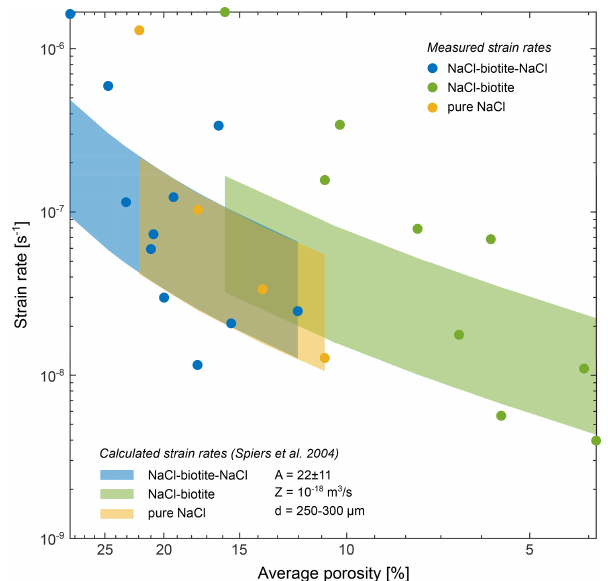
Figure 16. Comparison of bulk strain rates and calculated bulk strain rates based on the rate law by Spiers et al. (2004) for σ e (cid:127) S f (φ) with ˙ ε as the strain diffusion-controlled DPC: ˙ ε = A DCS RT d 3 rate, DCS = Z a phenomenological coefficient which represents the effective grain boundary diffusivity, d the grain size, σ e the effective axial stress, (cid:127) S the molar volume of the solid, R the gas constant, T the absolute temperature and f (φ) = 2 φ/( 1 − 2 φ) 2 as a function of the porosity ( φ ). For the calculation, the parameters A and Z were used as given in Spiers et al. (1990) and Spiers et al. (2004), respectively. The maximum strain rate was calculated for a geo- metrical constant A = 33 (6-fold coordination) and a grain size of d = 250µm. The minimum strain rate was similarly calculated for A = 11 (12-fold coordination) and d = 300µm. Our measured data broadly align with the calculated strain rates at the same porosity.